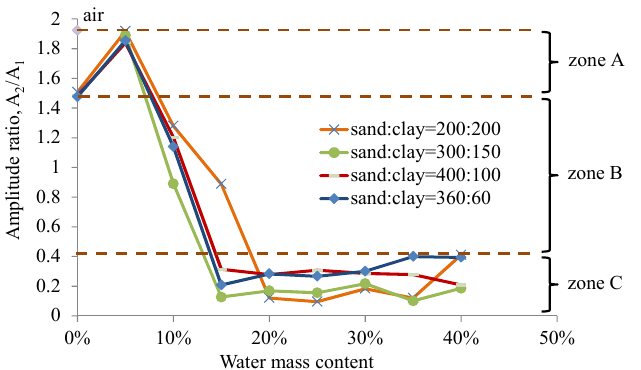
Figure 9. Amplitude ratio of ultrasound reflection from the front and back interface of the pipe material for, soil 1, sand and clay mass ratio of 1:1 (200 g:200 g), soil 2, sand and clay mass ratio of 2:1 (300 g:150 g), soil 3, sand and clay mass ratio of 4:1 (400 g:100 g), and soil 4, sand and clay mass ratio of 6:1 (360 g:60 g).